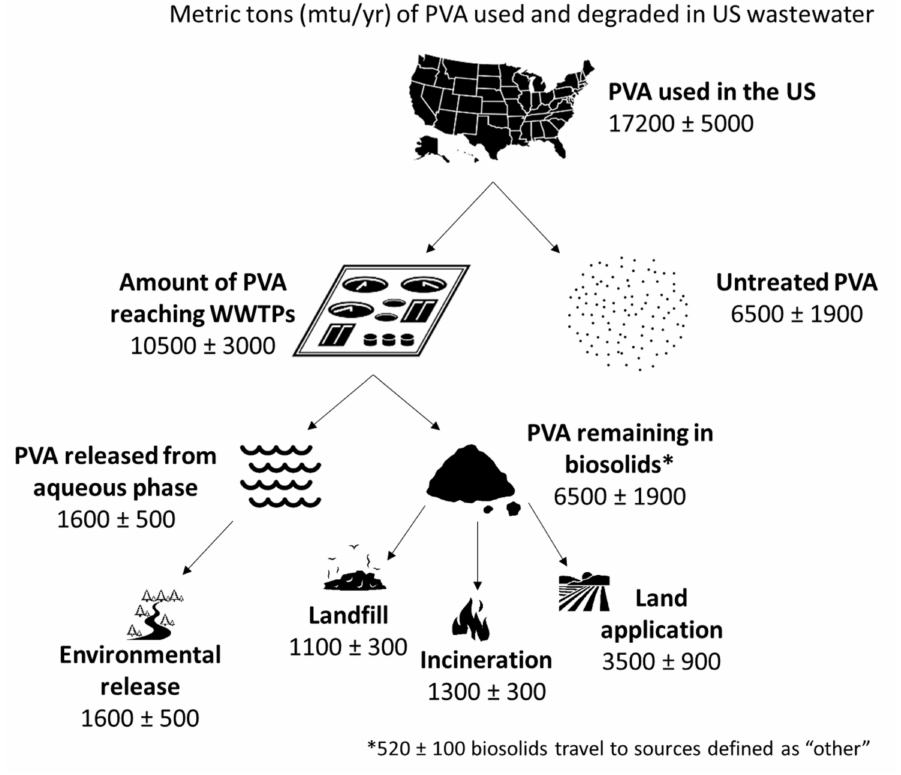
Figure 4. Modeled PVA usage and emissions in metric tons per year (mtu/yr) in the US. Once biosolids leave a WWTP facility, 50–60% are applied to agricultural lands, 20% are sent to be incinerated, and 17% are sent to a landfill [58]. Each of these locations carries environmental risks associated with the distribution of plastics from